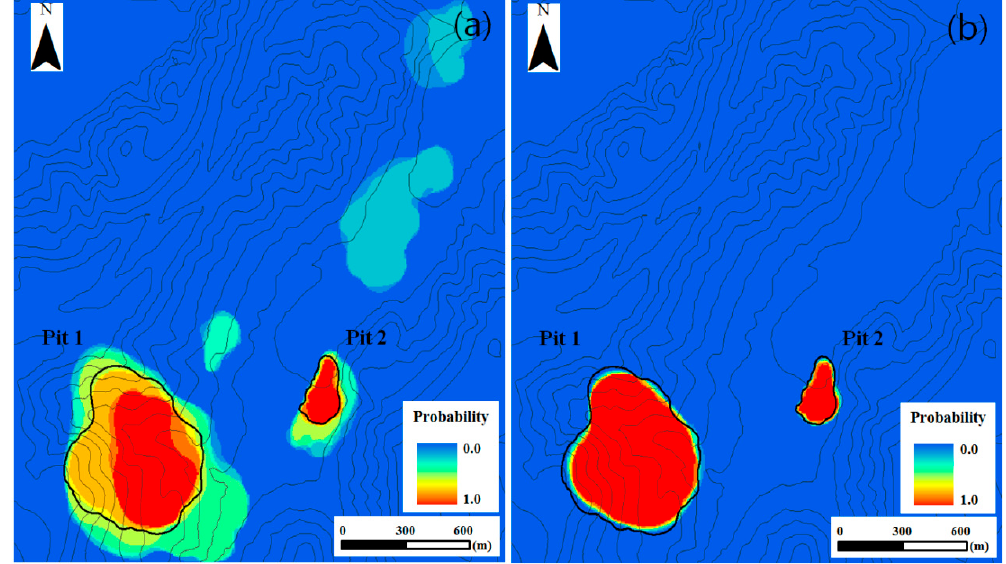
Figure 12. Probability model representing the uncertainty in the pit optimization results. ( a ) Case 1 when considering the variation of copper prices only; ( b ) Case 2 when considering the variation of zinc prices only.